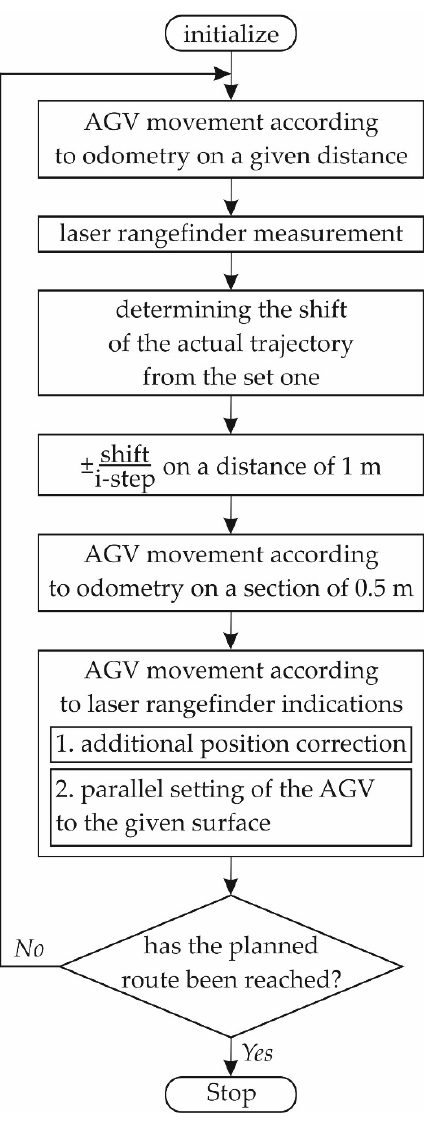
Figure 4. Automatic course correction algorithm.